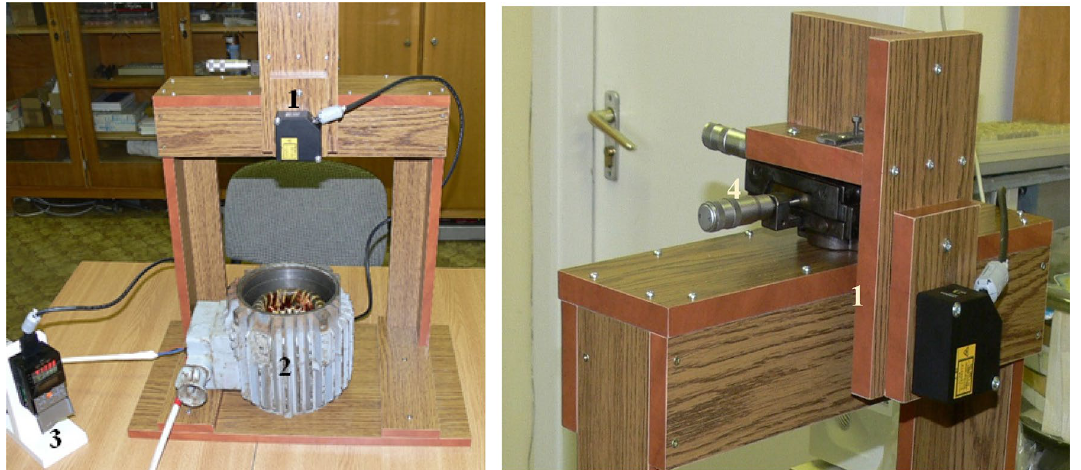
Figure 2. The unit for measuring the decrease in the level of the rotating metallic melt 1: laser, 2: inductor, and 3: display, 4:X – Y